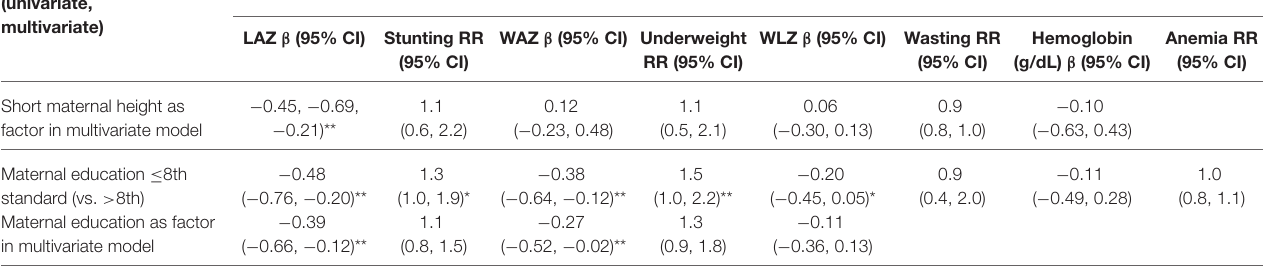
Continuous and dichotomous outcomes (Unadjusted univariate and adjusted multivariate